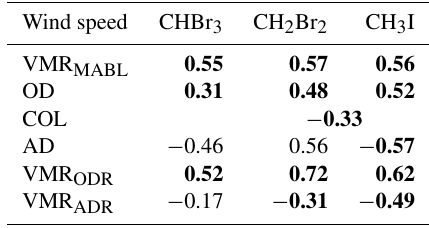
Table 5. Correlation coefficients between wind speed and VSLS MABL mixing ratios (VMR MABL ) , the oceanic delivery (OD), the convective loss (COL) to the FT, the advective delivery (AD), com- puted as the residual of OD, and the mixing ratios originating from the OD (VMR ODR ) and from the AD (VMR ADR ) of each com- pound. Bold numbers are significant at the 95 % level ( p value).